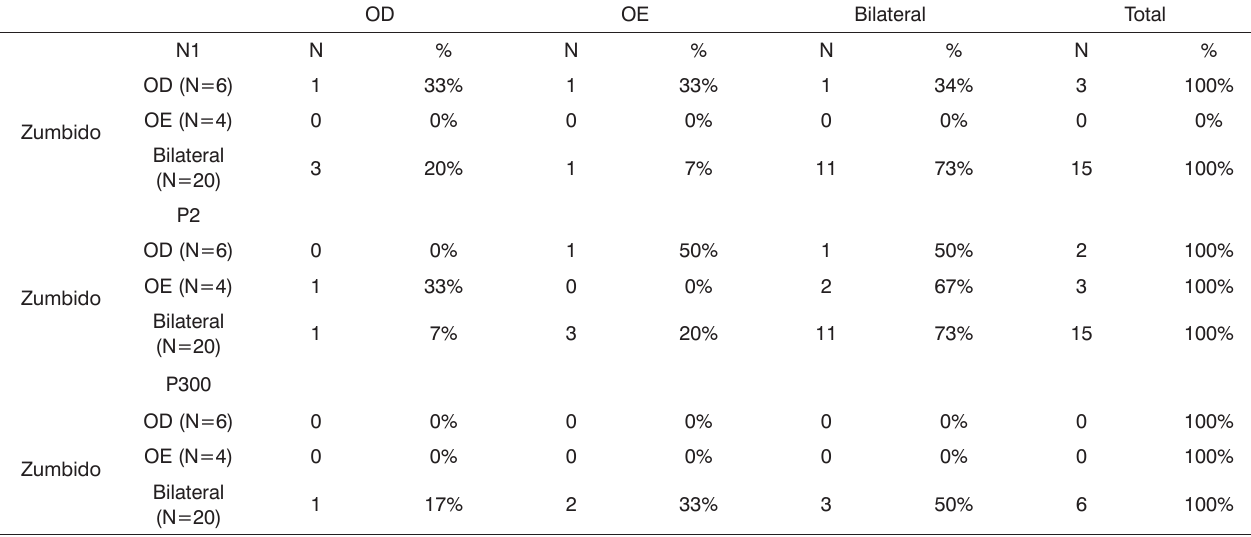
Tabela 4. Associação entre o lado da alteração nos componentes N1, P2 e P300 do PEALL e a localização do zumbido no grupo pesquisa